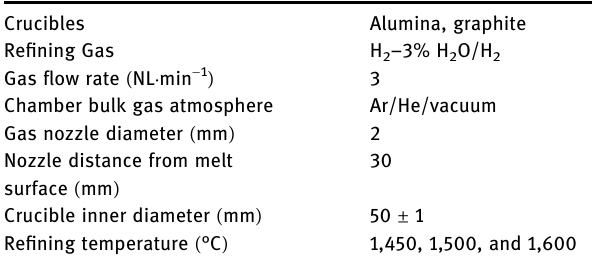
Table 2: The experimental conditions of the gas re fi ning